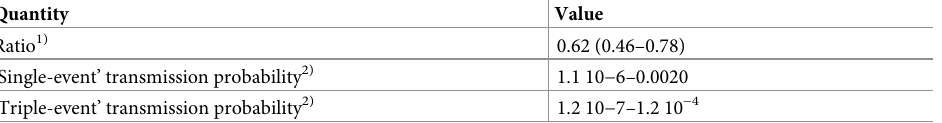
Table 4. The risk of HPAI transmission jumps from one area to another, due to a compartment with one farm located in the DPPA and with transport of animals (chicken) and eggs.